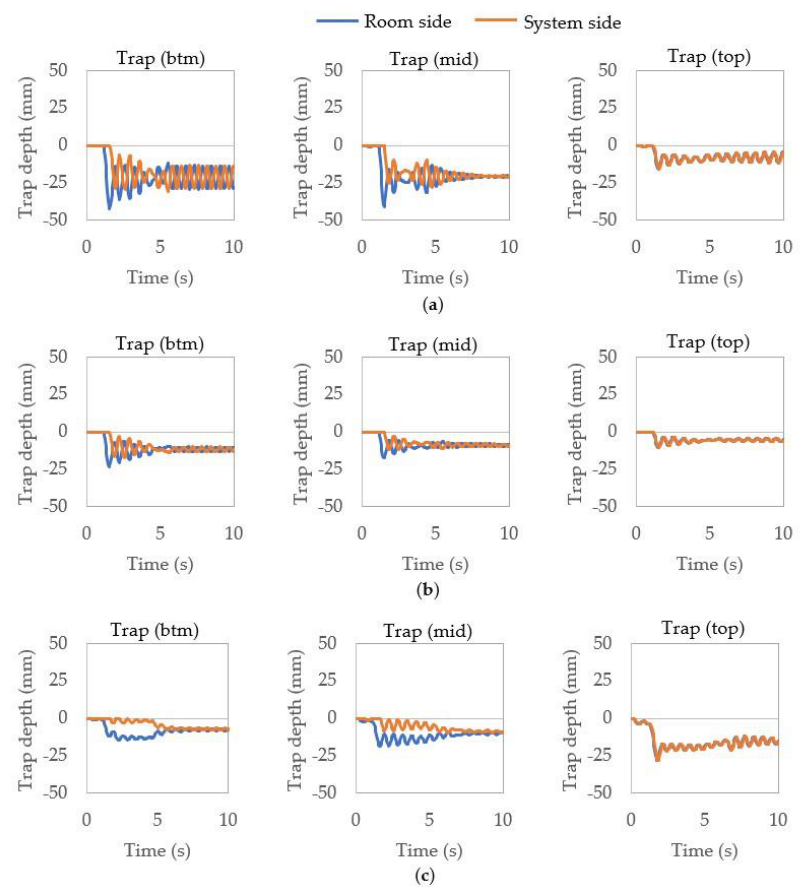
Figure 6. Simulated water-trap seal fluctuations for the 10 story building with 100 mm diameter stack in system configurations: ( a ) single-stack; ( b ) fully‐vented; and ( c ) single-stack with air admittance valves (AAVs). The operational performance elements of stack pressure profiles, airflows, and re- sultant trap retention depths for the 10 story building with a 100 mm diameter stack are shown in Figure 7 for the same three system configurations of single-stack, fully‐vented, and single-stack with AAVs. The stack pressure profiles are displayed for four timesteps (1.5 s, 3.0 s, 4.25 s, and 6.0 s) across the simulation test period. The profile can be seen to change during the appliance water discharge (varying from atmospheric pressure before the water discharge begins, to a maximum negative pressure towards the base of the stack during full discharge flow, before then returning to atmospheric pressure once the water discharge has ended). The maximum negative pressure in the single-stack system reaches almost −40 mm water gauge (wg) at 4.25 s. This reduces to −10 mm wg for the fully‐vented system, showing a clear improvement to the operational performance of the system due to the increased ventilation. The stack pressure profile of the single-stack with AAVs is quite